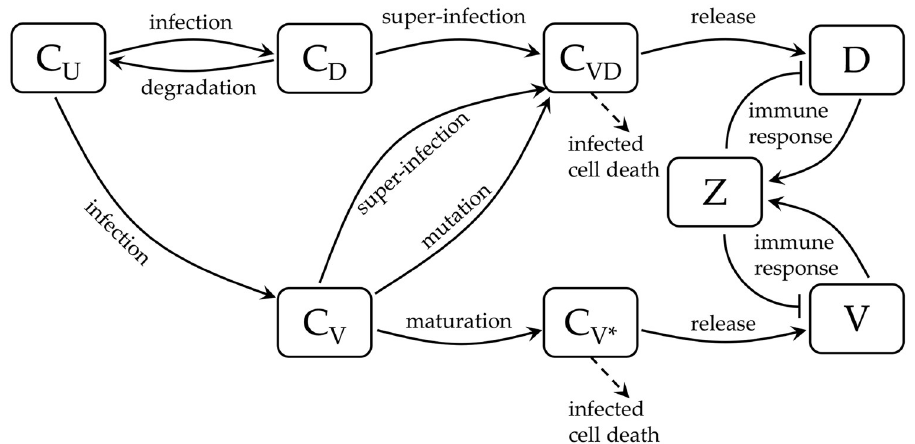
Fig 1. Schematic diagram of the within-host dengue virus infection dynamics. The uninfected target cells ( C ) can U be infected by either virus particles ( V ), or defective particles ( D ) to generate early infected C V and C D cells. The C D cells can either be transformed into C cells by super-infection, or come back to uninfected state ( C ) by losing the VD U DI particles. C V cells can also be transformed into C VD cells either being infected by DI particles or through mutation of the virus genomes inside it. Otherwise, C cells mature to late infected C cells. The C and C cells are able to V V � VD V � replicate and release the defective particles and the standard dengue virus, respectively. The occurrence of viral particles of any kind ( V and/or D ) in the blood plasma triggers the antibody response ( Z ), which in turn prevents the infected cells ( C and C ) at virus production. The cell death has been considered only for C and C infected cells VD V � VD V � as the other two infected cells ( C D and C V ) transform themselves quickly into other states.